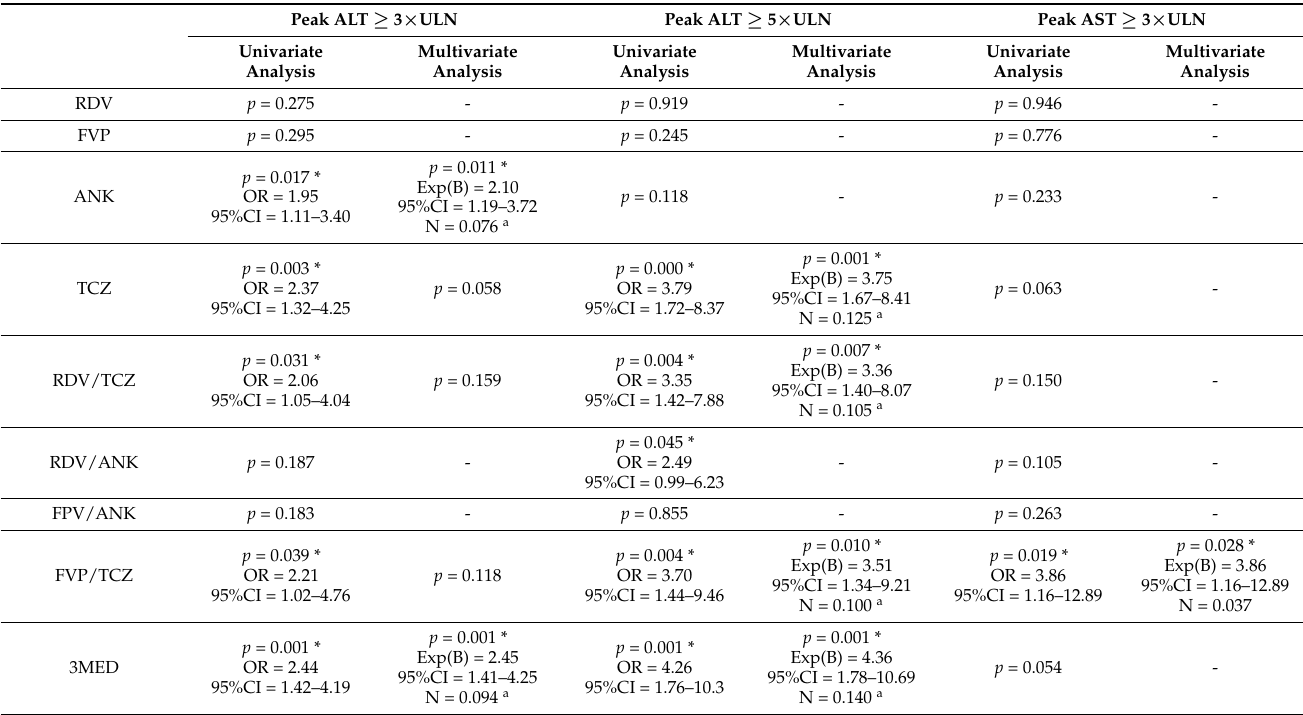
Table 5. Correlations between grade 2 and grade 3 increase in liver cytolysis enzymes and COVID-19